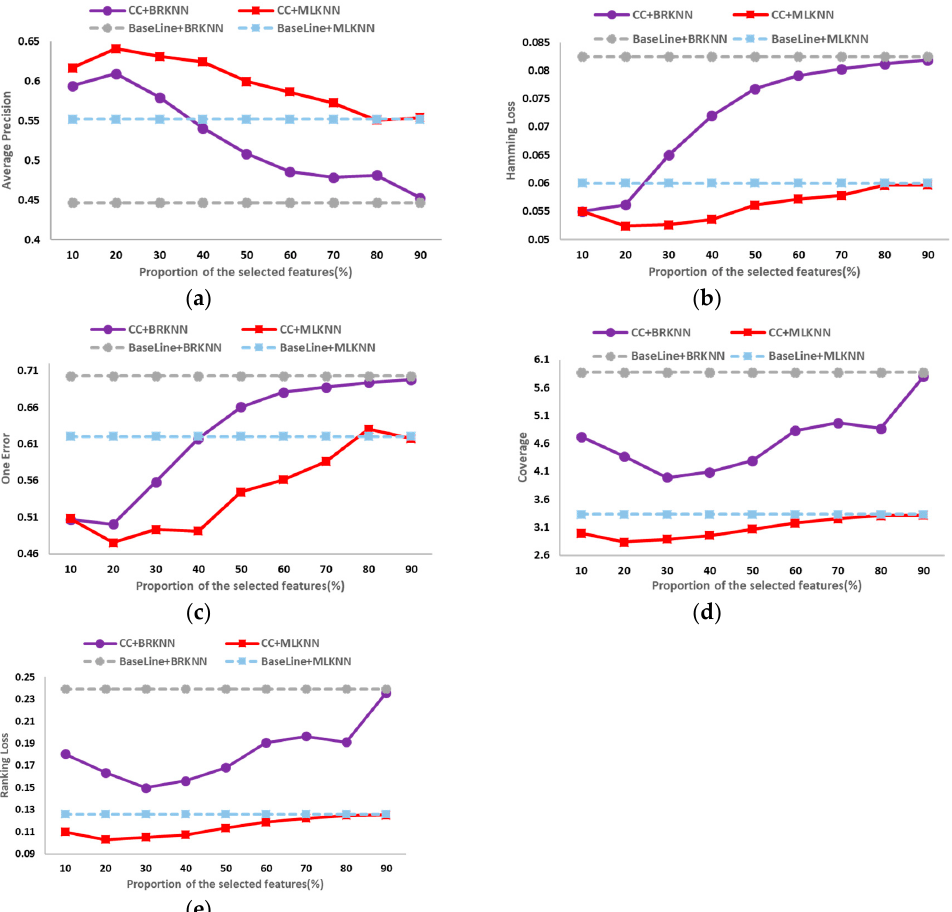
Figure 5. Experimental results on Entertainment data set. ( a ) Average Precision; ( b ) Hamming Loss; ( c ) One Error; ( d ) Coverage; ( e ) Ranking